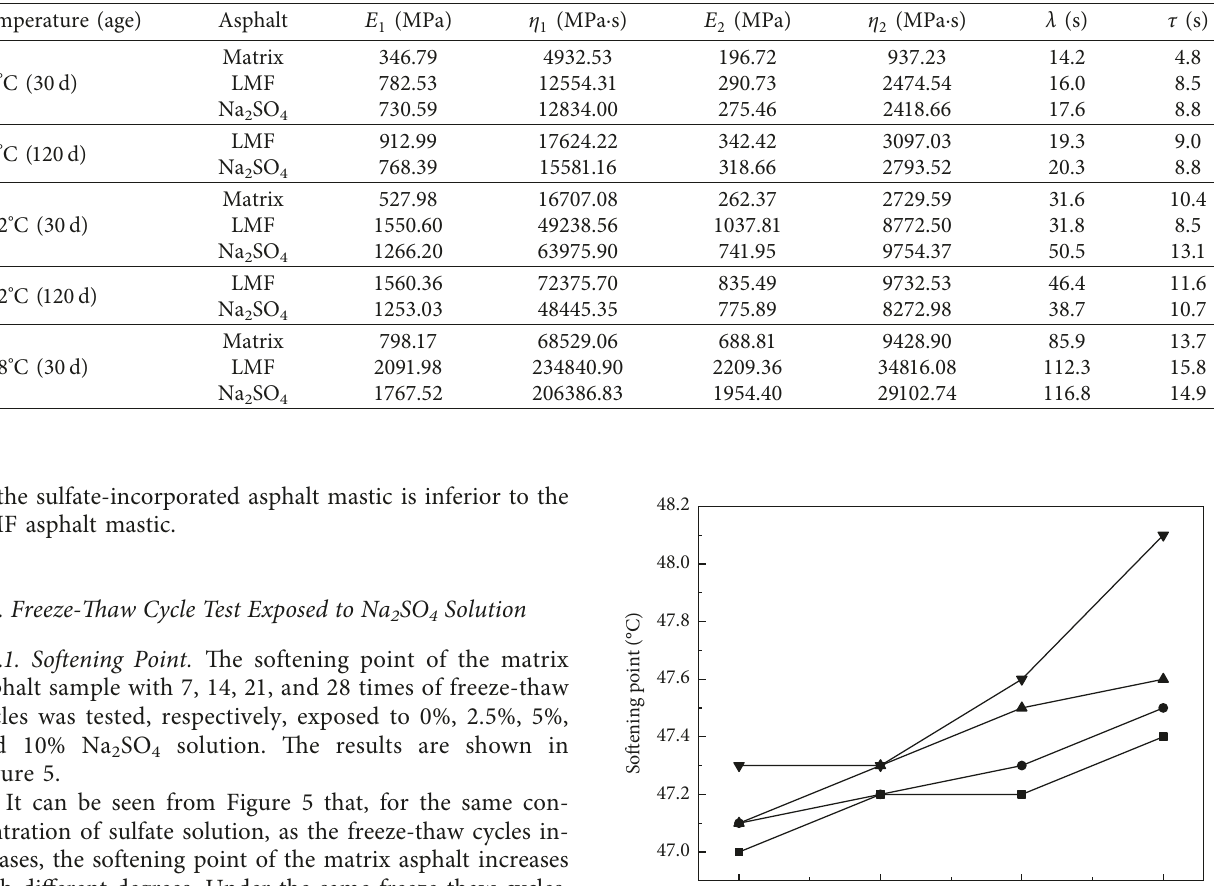
Figure 4: Stiffness modulus S and creep rate m of asphalt mastic at different temperatures. Table 6: Results of Burgers’ parameters of asphalt mastics at different temperatures.